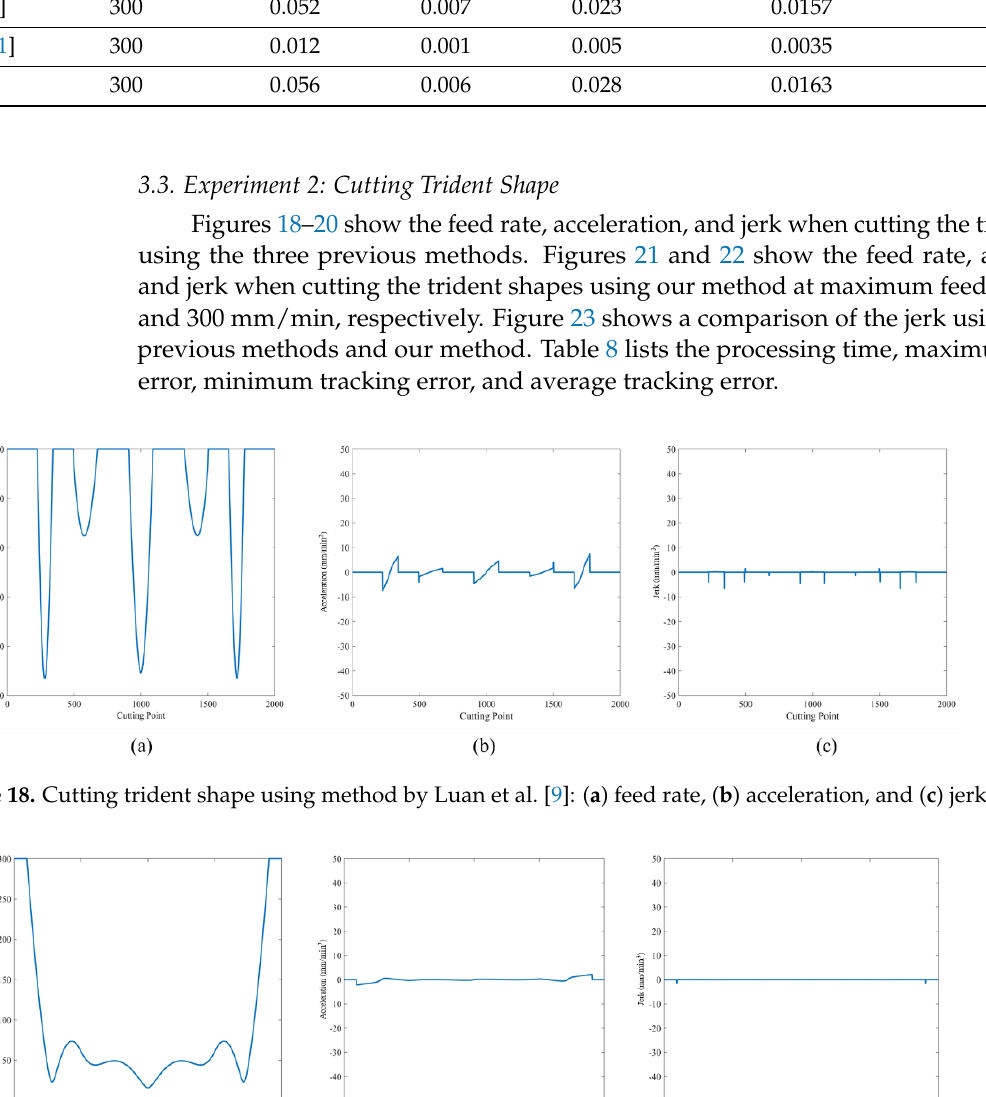
Figure 20. Cutting trident shape using method by Giannelli et al. [11]: ( a ) feed rate, ( b ) acceleration, and ( c ) jerk.